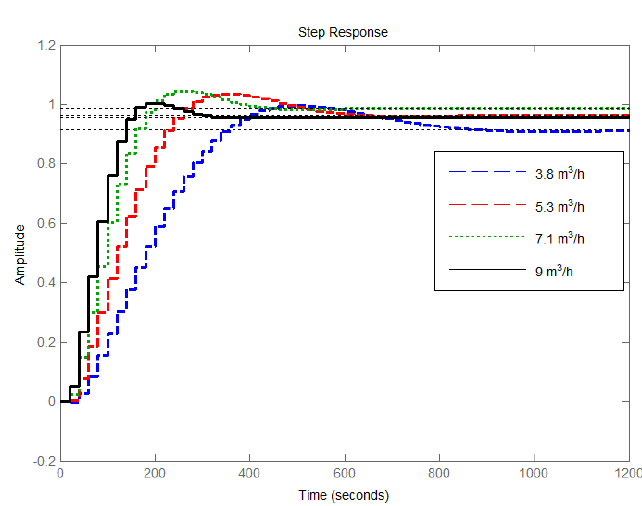
Figure 11. Linear models step response for different water flow conditions.